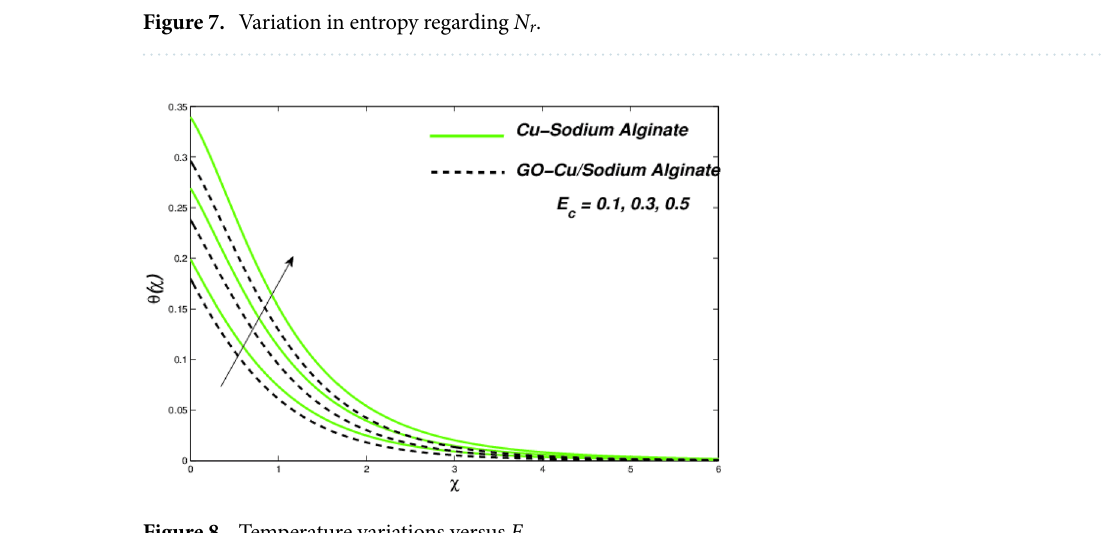
Figure 8. Temperature variations versus E c .